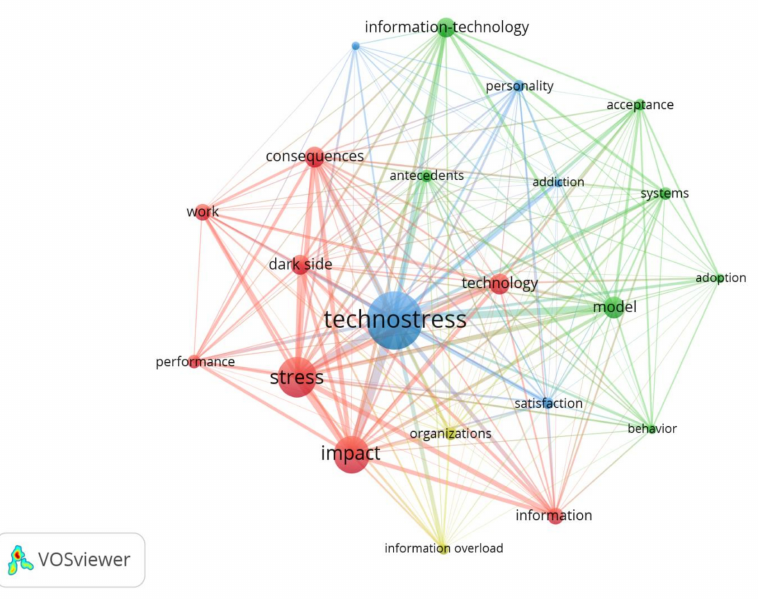
Figure 6. Co-words graph based on keywords plus